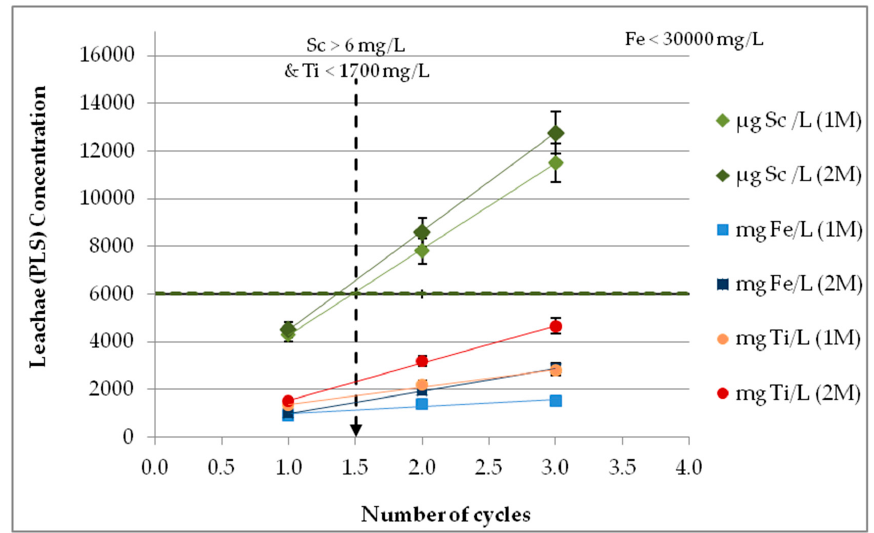
Figure 8. Leachate recycling with pH adjustment (S/L 10%, 1 and 2 M H 2 SO 4 , pH ≈ 0, t = 60 min,